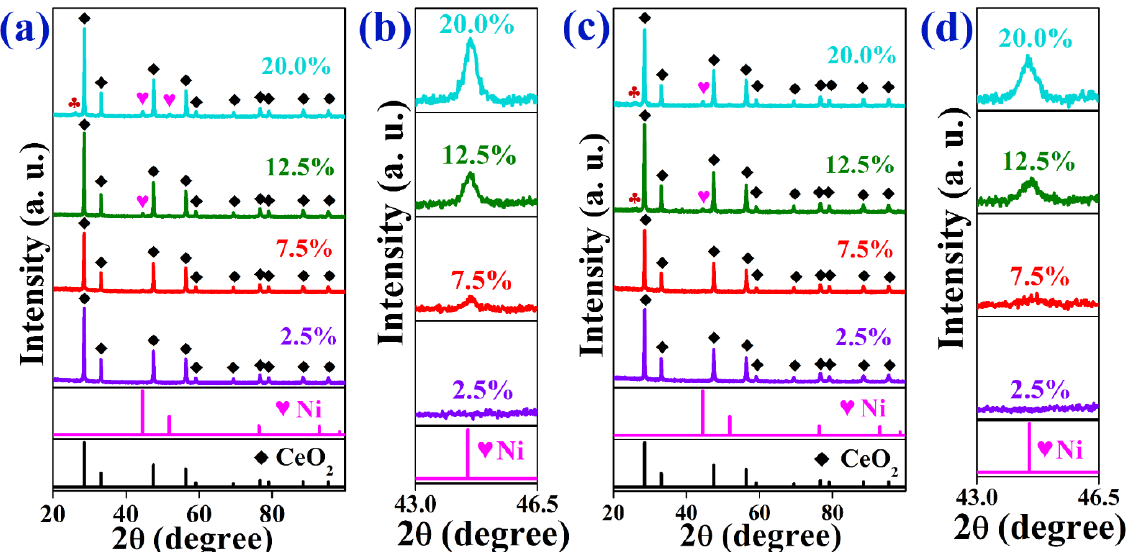
Figure 8. PXRD patterns of the Ni@CeO 2 catalysts prepared at different Ni-loadings (2.5, 7.5, 12.5, and 20 wt%) after operating the DRM reaction for 50.0 h at temperatures of 800 °C ( a ) and 700 °C ( c ). ( c ) PXRD patterns at a slow scanning speed of 0.6°/min of the Ni@CeO 2 catalysts (2θ = 43.0–46.5°), after operating the DRM reaction for 50.0 h at temperatures of 800 °C ( b ) and 700 °C ( d ).